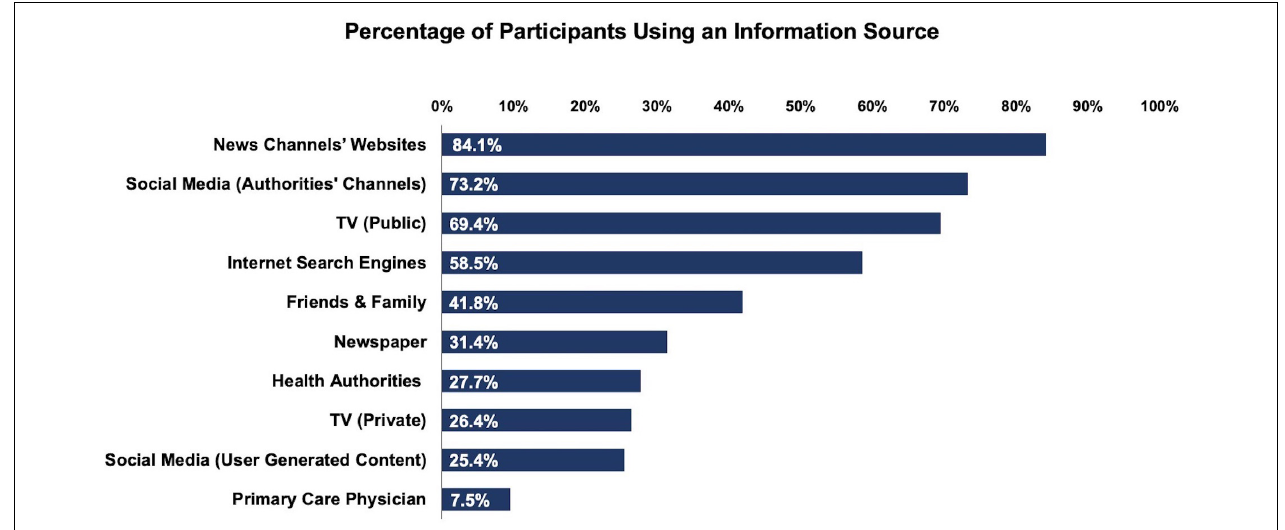
FIGURE 1 | Percentage of participants reporting to use each source to obtain information about